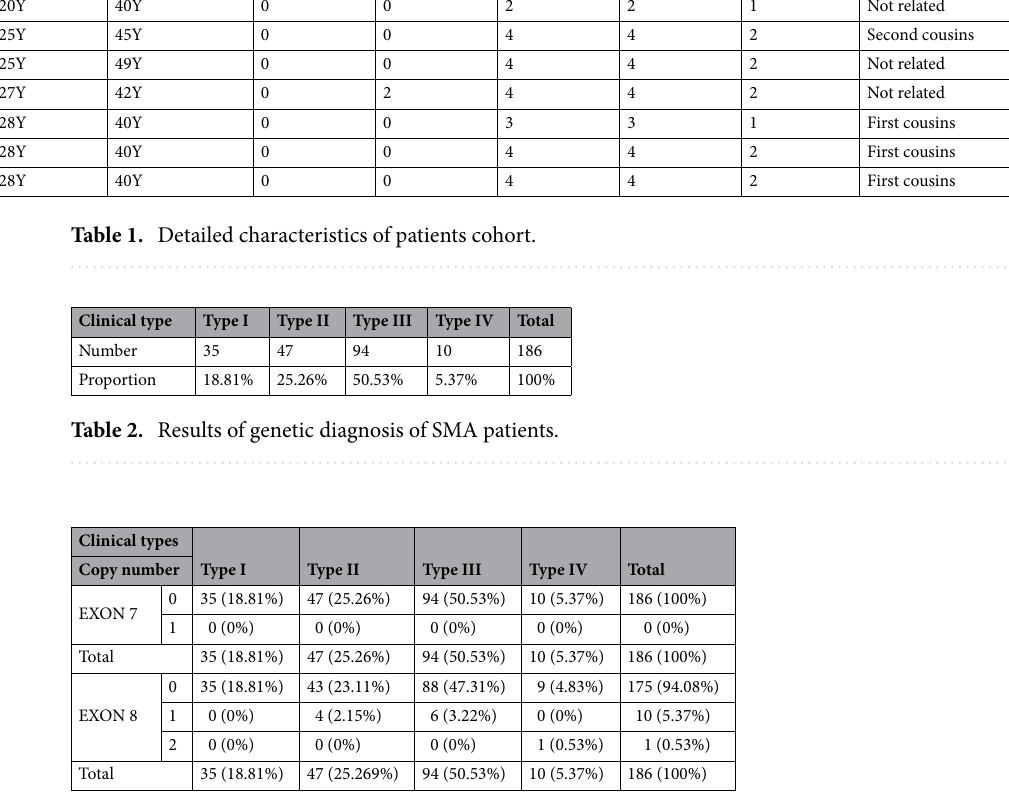
Table 3. SMN1 Exons copy numbers in patients with different clinical types of